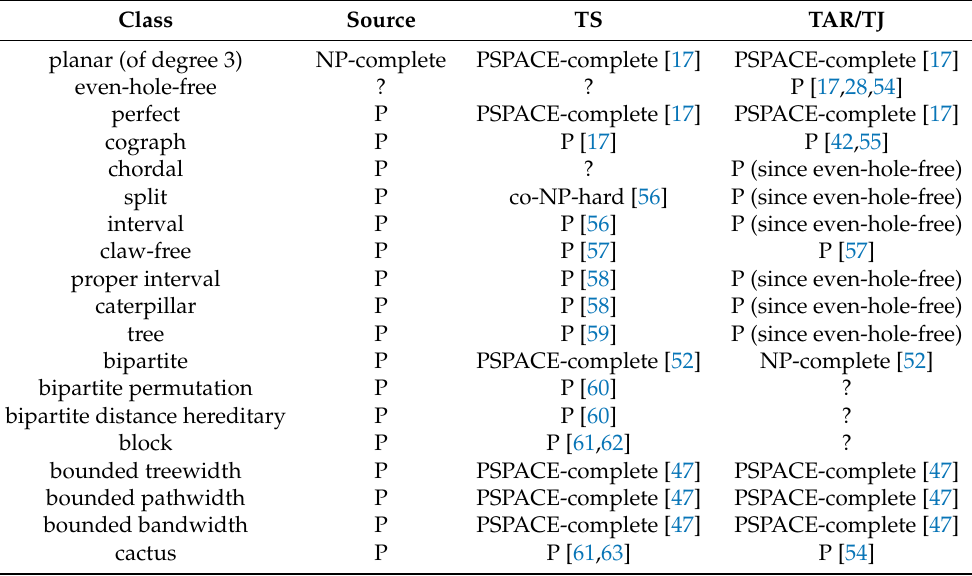
Figure 5. Complexity of reachability for I NDEPENDENT S ET R ECONFIGURATION ; graph classes are divided by complexity for the source problem (solid lines), TAR/TJ (dotted lines), and TS (dashed lines). The dotted-and-dashed line is a dividing line for both TAR/TJ and TS. Table 1. Results on reachability for I NDEPENDENT S ET R ECONFIGURATION ; question marks indicate problems for which there are no known complexity